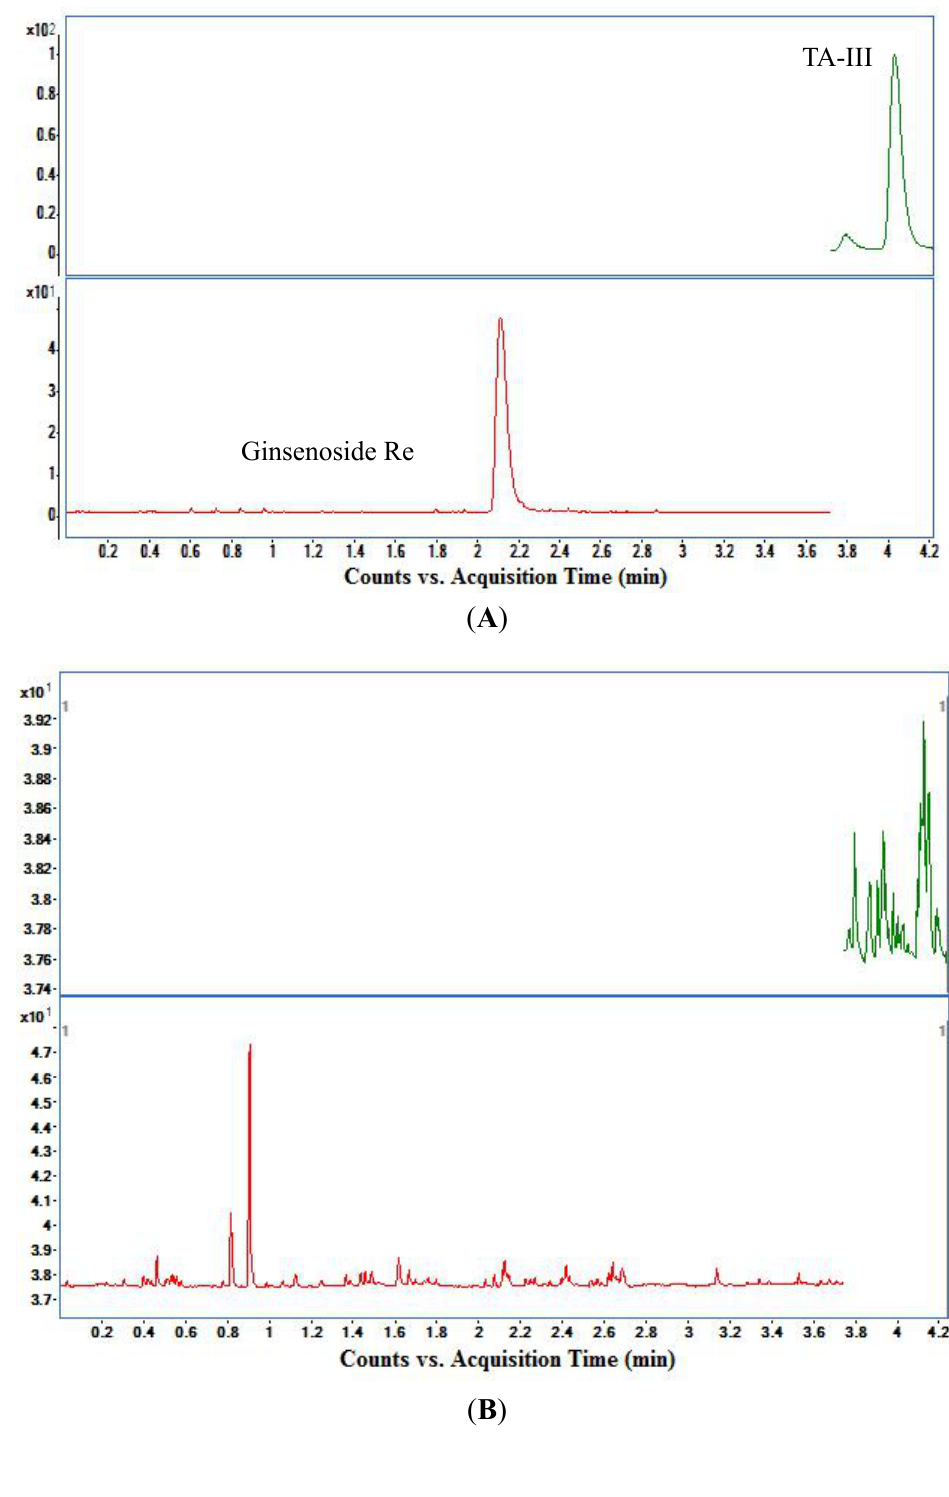
Figure 4. Representative MRM chromatograms of TA-III and IS for ( A ) a plasma sample from a rat subject collected at 0.5 h after an oral dose of 50 mg/kg TA-III; ( B ) a blank rat plasma; ( C ) a spiked sample at the concentration of 557.0 ng/mL for TA-III and 1480 ng/mL for